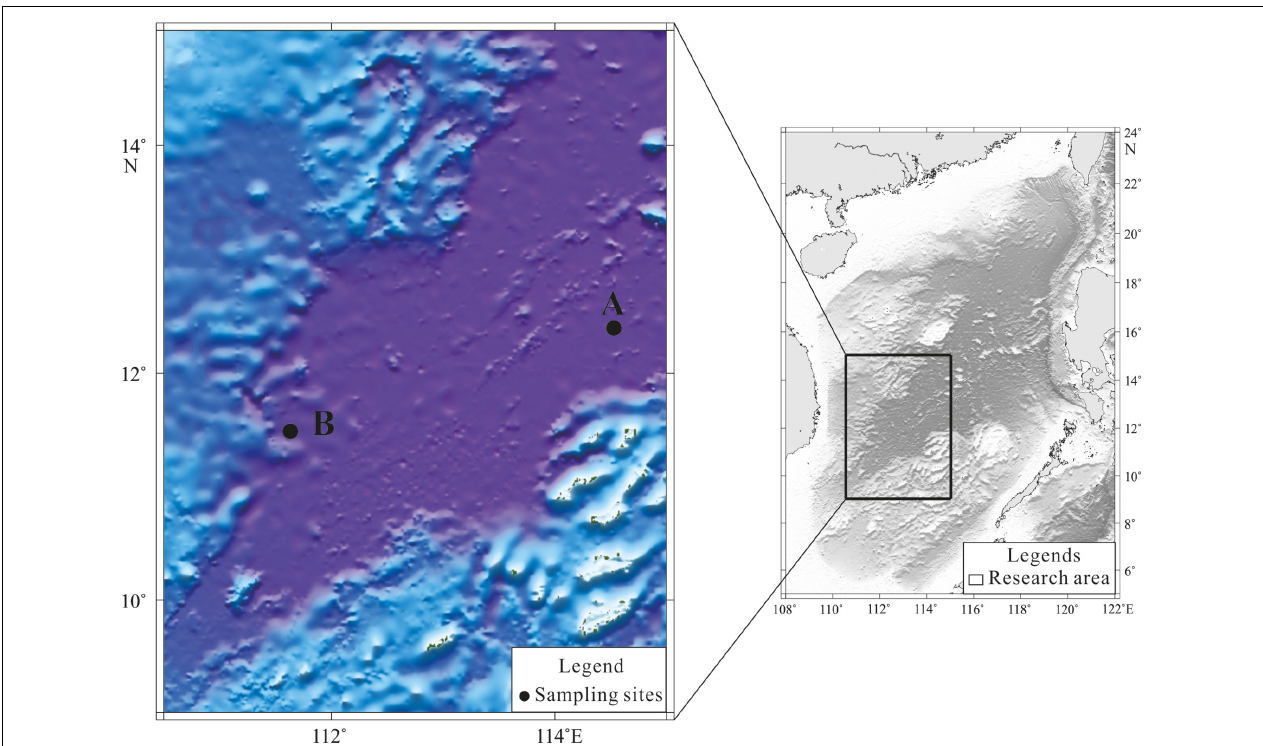
FIGURE 1 | The distribution of sampling sites and the tectonic location of the Southwest